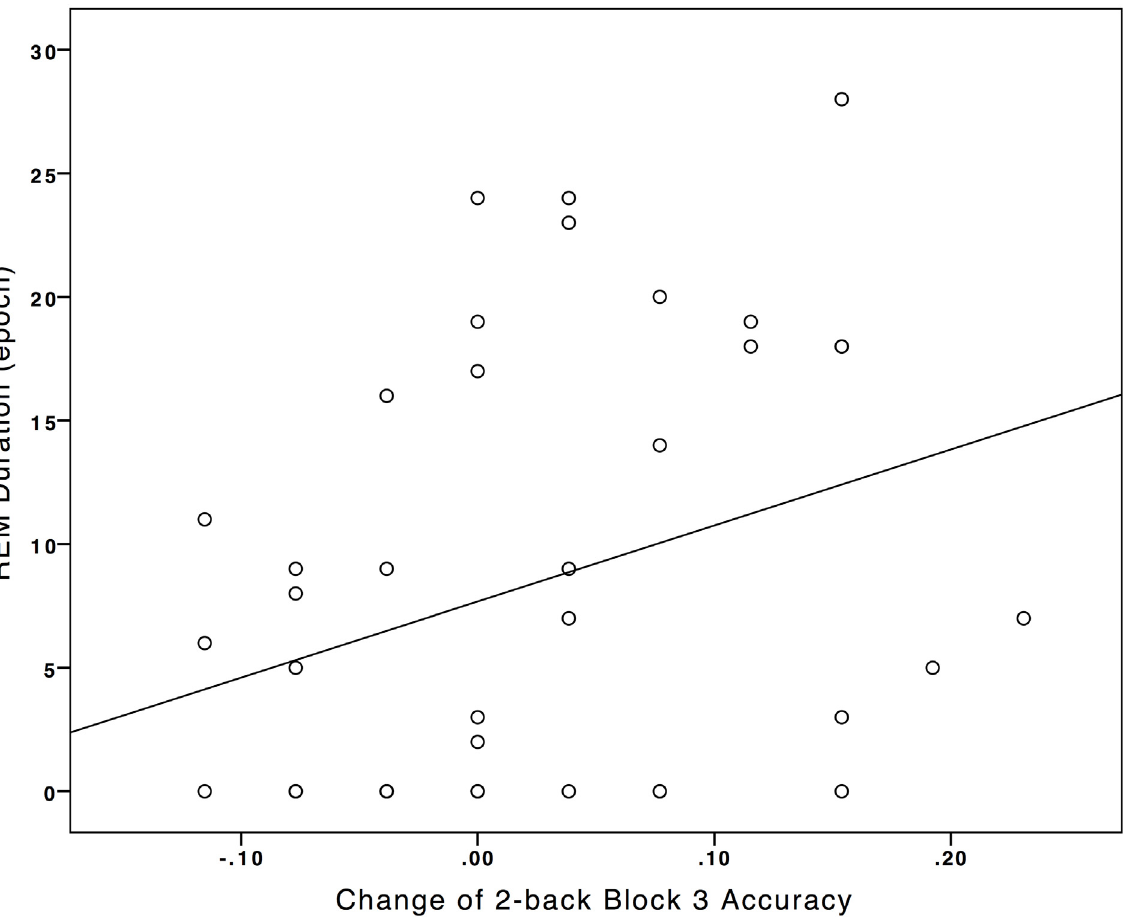
Fig 3. Association between Rapid-eye-movement-sleep duration with the pre/post-condition difference of 2-back Block 3 Accuracy.